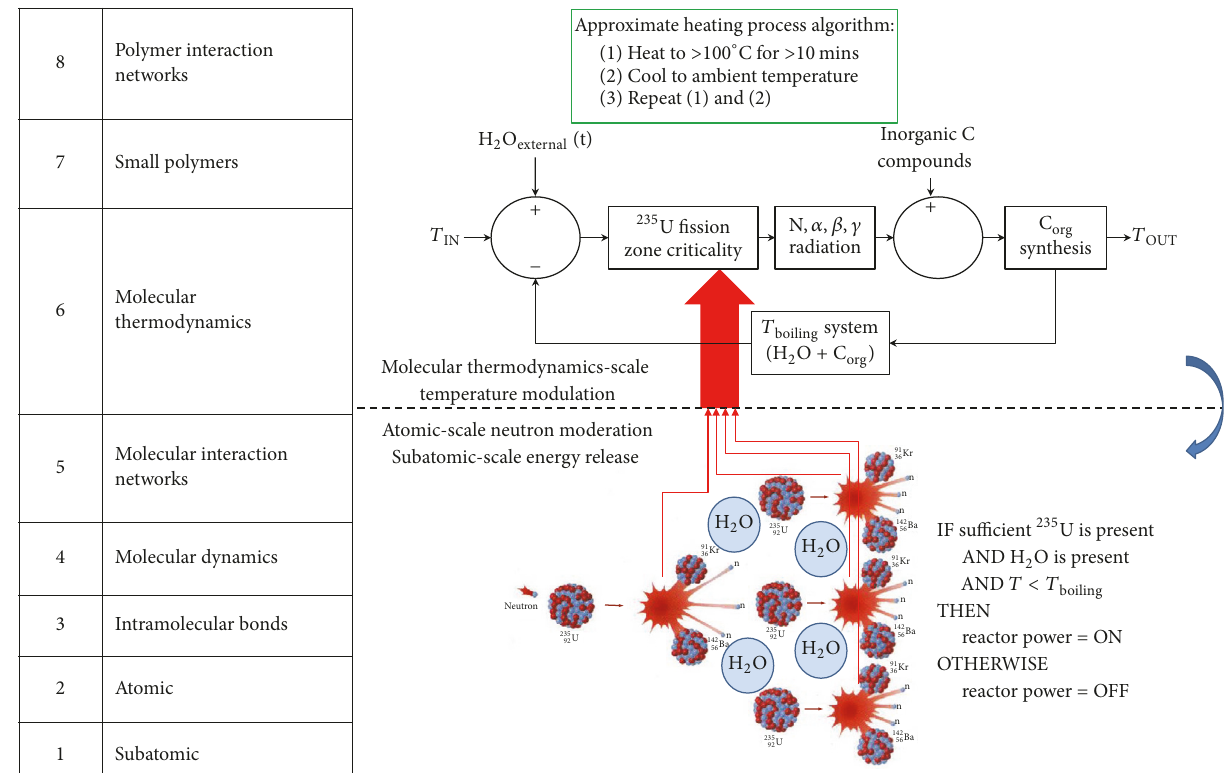
Figure 5: An approximated temperature feedback control diagram of a natural 235 U water-moderated and cooled fission zone. Thermostatic feedback is an emergent property spread between subatomic, atomic, and molecular levels of energy attenuation. The maximum temperature of the thermostat is governed by the boiling temperature of the moderating fluid, which is most likely water but may also include organic carbon compounds produced via radiolysis of inorganic